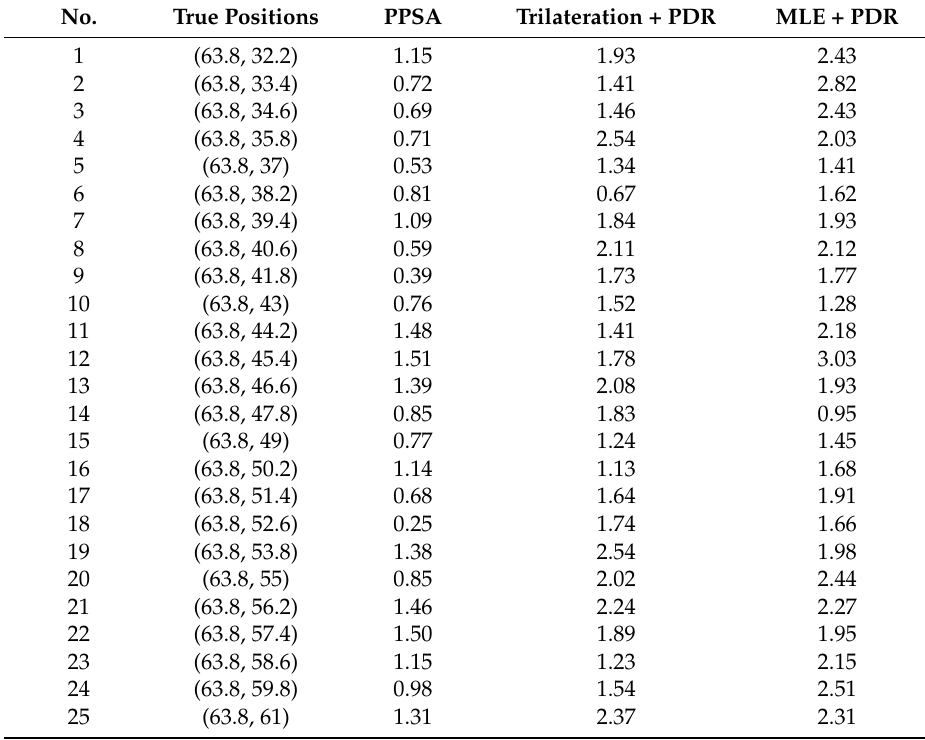
Table 4. The localisation errors of the three